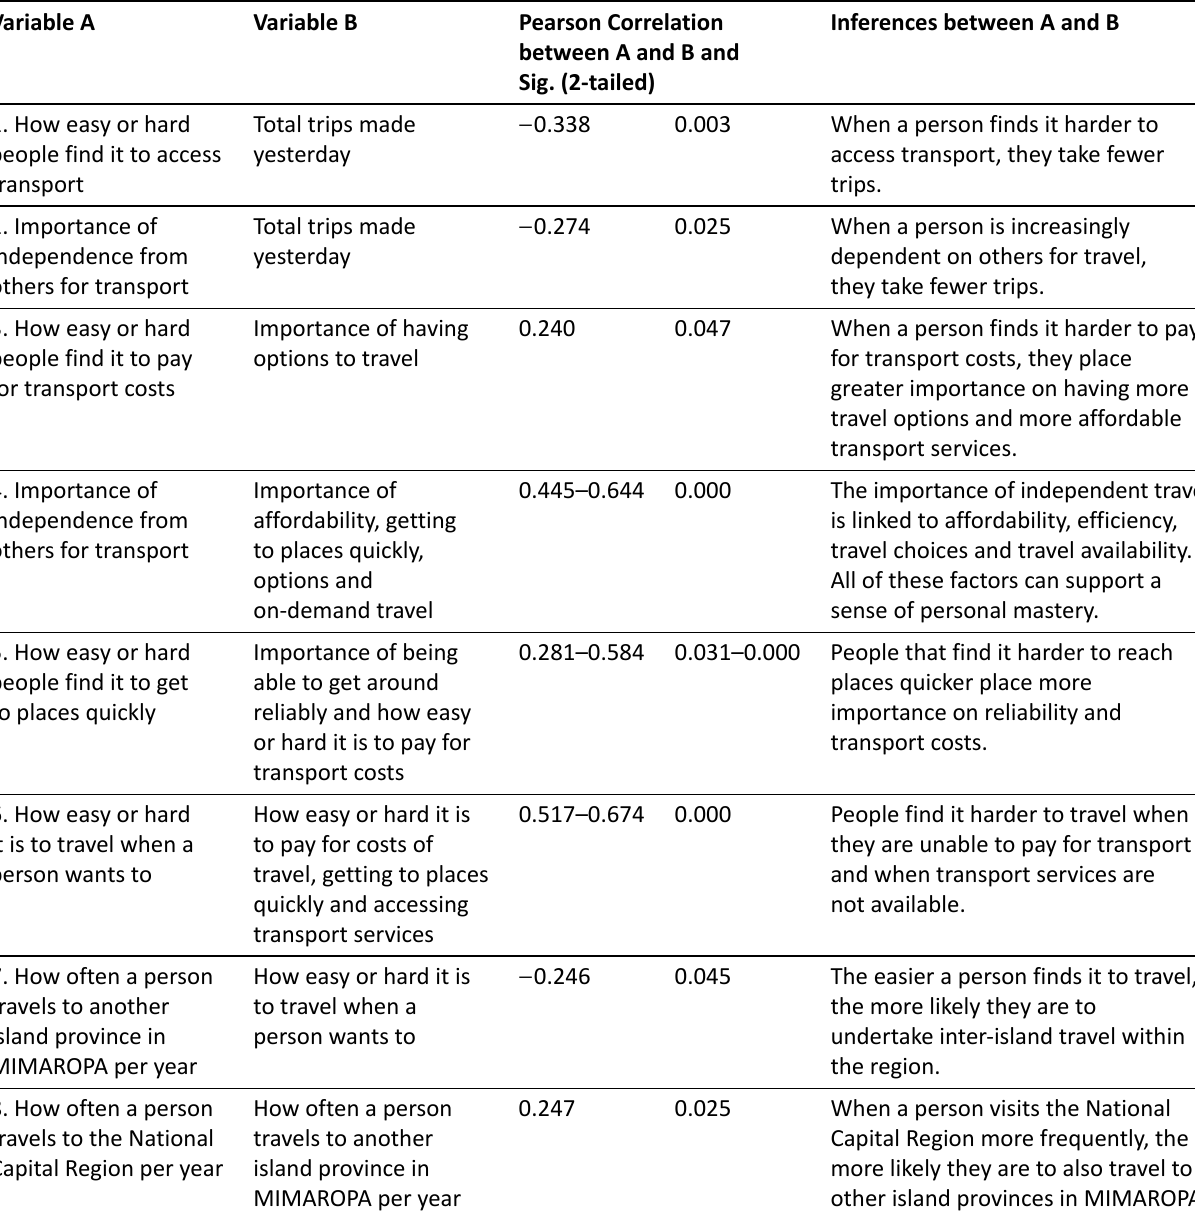
Table 2. Significant relationships in the bivariate correlation analysis Variable